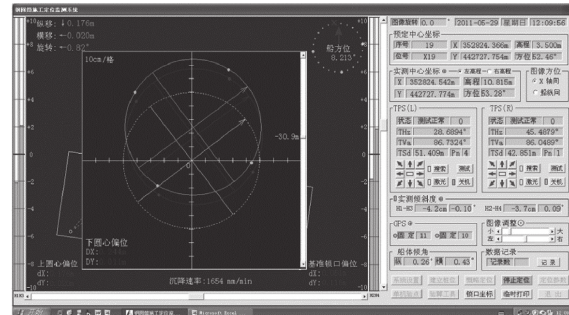
Figure 22: Monitoring and location system visualization platform.